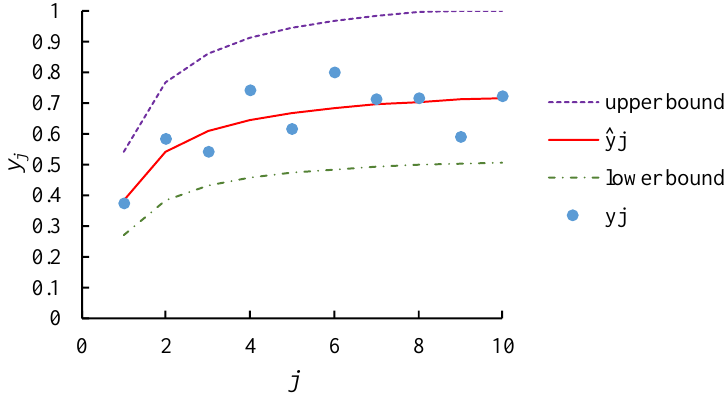
Figure 12. Forecast results found when the 6 σ logistic regression method.